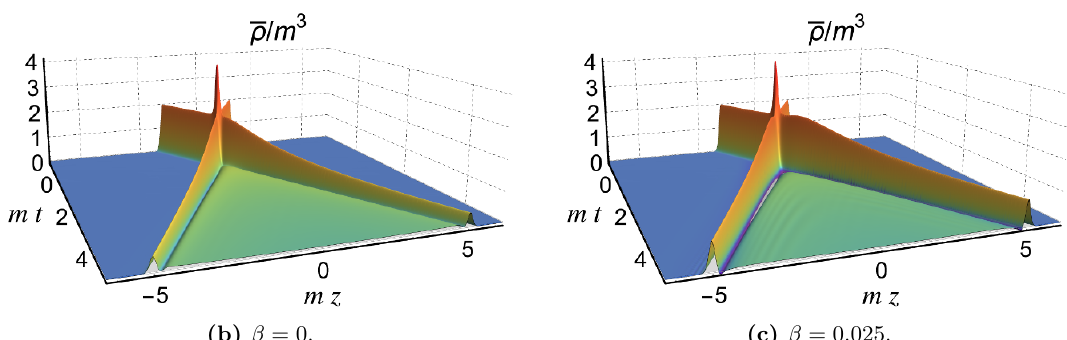
= (cid:0) 0 : 2 in the (cid:15) = 0 limit. GB